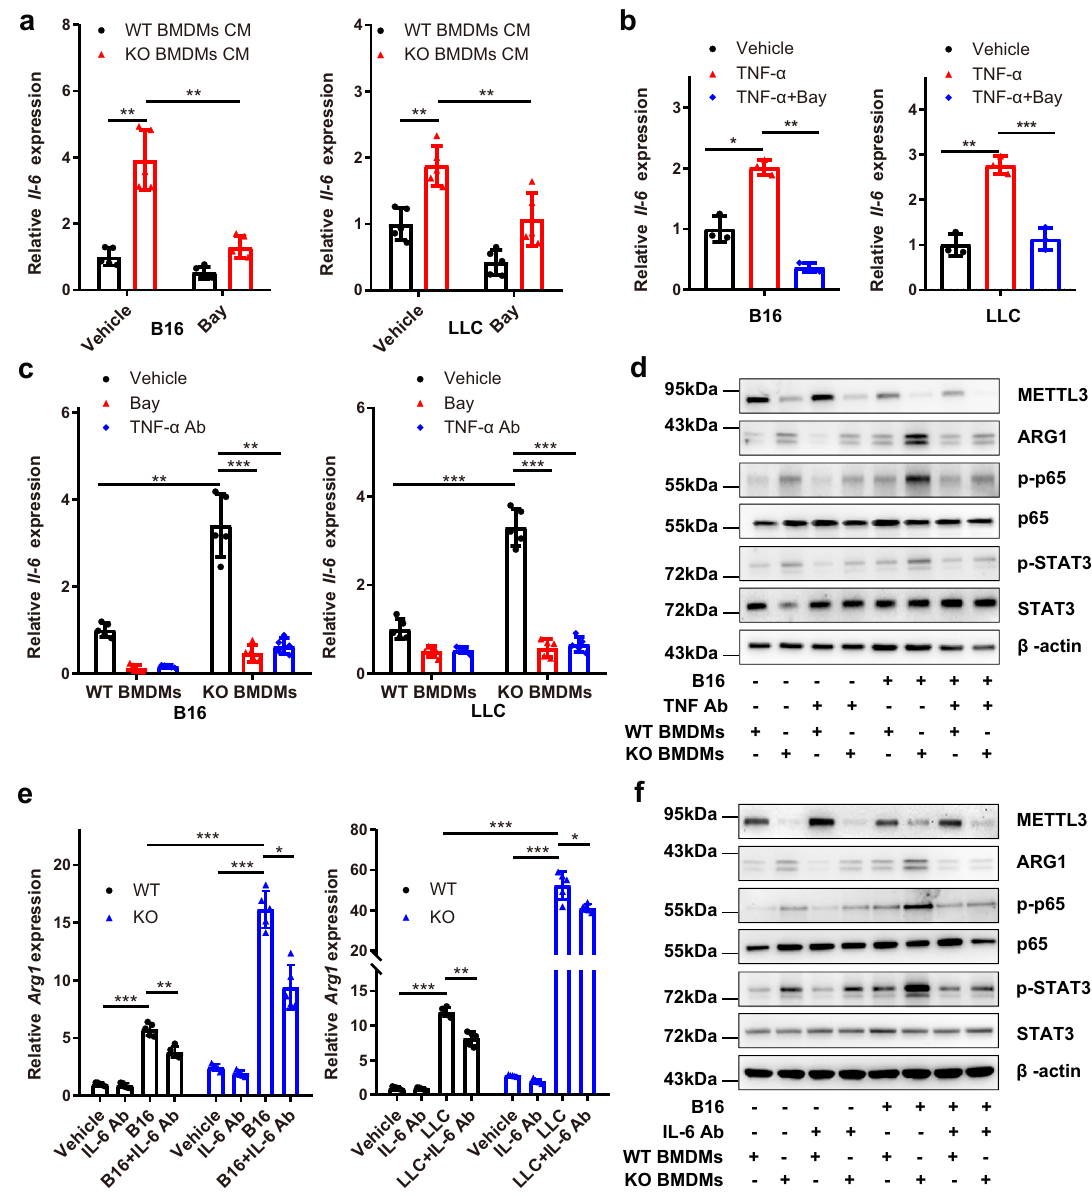
Fig. 5 Production of cytokines and activation of NF- κ B and STAT3 are enhanced in Mettl3 -null macrophages co-cultured with tumour cells. a qRT-PCR analysis of Il-6 expression levels in B16 and LLC cells incubated with WT or KO BMDM culture medium for 24 hours in the presence or absence of BAY-11- 7082 (5 µ M) ( n = 5 mice per group). b B16 and LLC cells were treated with TNF- α (40 ng/mL) or TNF- α + BAY-11-7082 (5 µ M), followed by qRT-PCR analysis of Il-6 . n = 3 independent experiments. c B16 and LLC cells co-cultured with WT or KO BMDMs in the presence of BAY-11-7082 (5 µ M) or an anti- TNF- α Ab (20 µ g/mL) for 8 h. qRT-PCR analysis of Il-6 expression levels in WT or KO BMDMs was performed ( n = 5 mice per group). d Western blot analysis of the indicated proteins in WT and KO BMDMs co-cultured with B16 cells in the presence or absence of the anti-TNF- α Ab (20 µ g/mL). The blots are representative of n = 3 independent experiments. e qRT-PCR analysis of Il-6 expression in WT and KO BMDMs co-cultured with B16 or LLC cells in the presence or absence of an anti-IL-6 Ab (20 µ g/mL) ( n = 5 mice per group). f Western blot analysis of the indicated proteins in WT and KO BMDMs co- cultured with B16 cells in the presence or absence of the anti-IL-6 Ab (20 µ g/mL). The blots are representative of n = 3 independent experiments. Data are shown as the mean ± SD. P values were determined by a two-tailed t -test ( a – c and e ). * P ≤ 0.05, ** P < 0.01 and *** P < 0.001. The source data are provided as a Source data fi